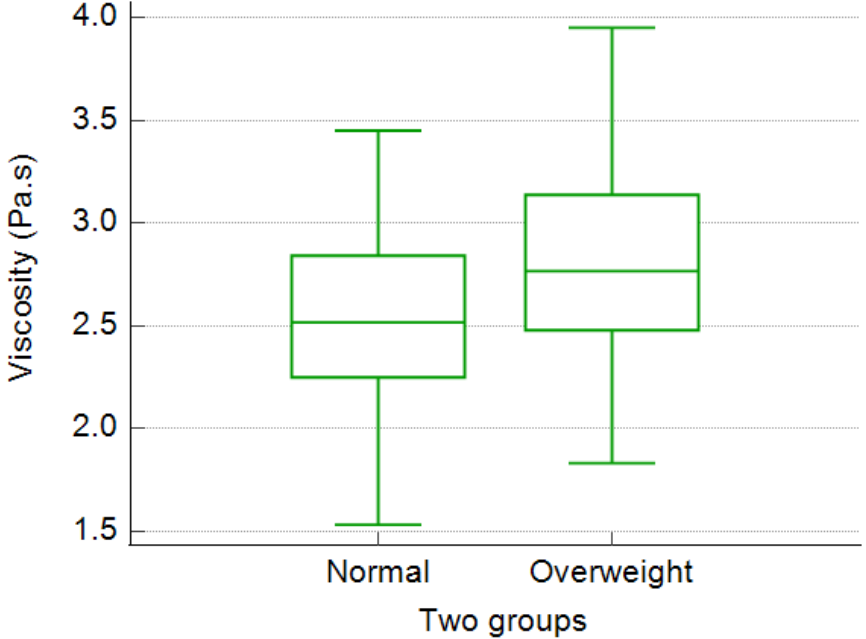
Figure 2. Boxplot diagrams illustrating the differences in mean normal viscosity values of thyroid parenchyma between normal weighted and overweighted groups. Table 6. Mean viscosity and stiffness values of the thyroid parenchyma in the healthy volunteers group according to BMI.